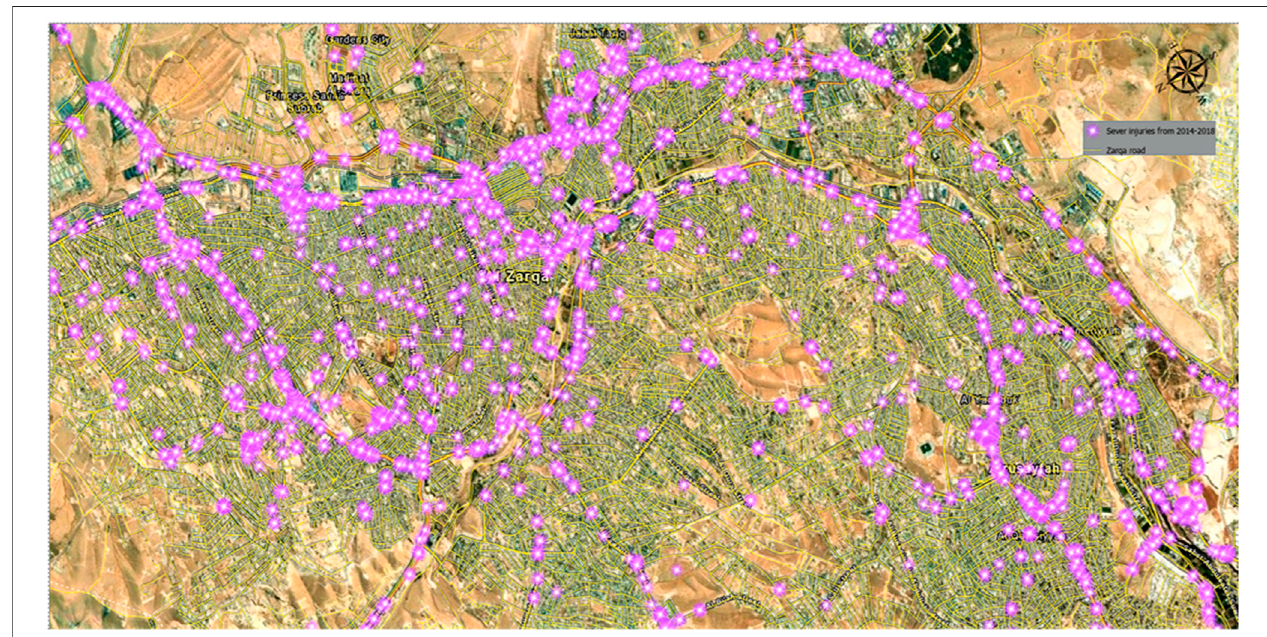
FIGURE 9 | Severe injury crashes for Zarqa City in 2014 – 2018.